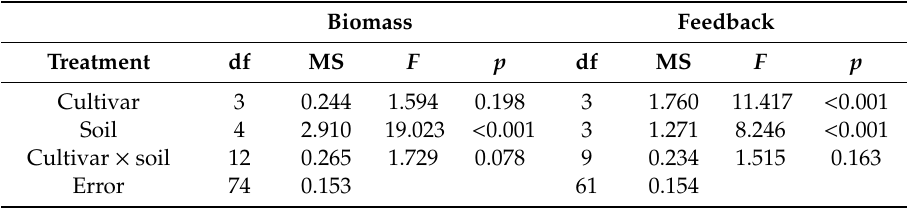
Figure 2. Total biomass ( A , B ) and biomass feedback ( C , D ) as a function of switchgrass cultivar ( A , C ) and soil inoculum source ( B , D ). Hatches show the portion of total biomass in roots. Bars are means ± 95% CI (biomass) or 1 SE (feedback) with n = 22–24 for cultivar and n = 17–20 for soil inoculum source. Letters indicate significant differences in posthoc comparisons. Table 4. ANOVAs for biomass and biomass feedback as a function of plant cultivar, soil inoculum source, and their interaction.